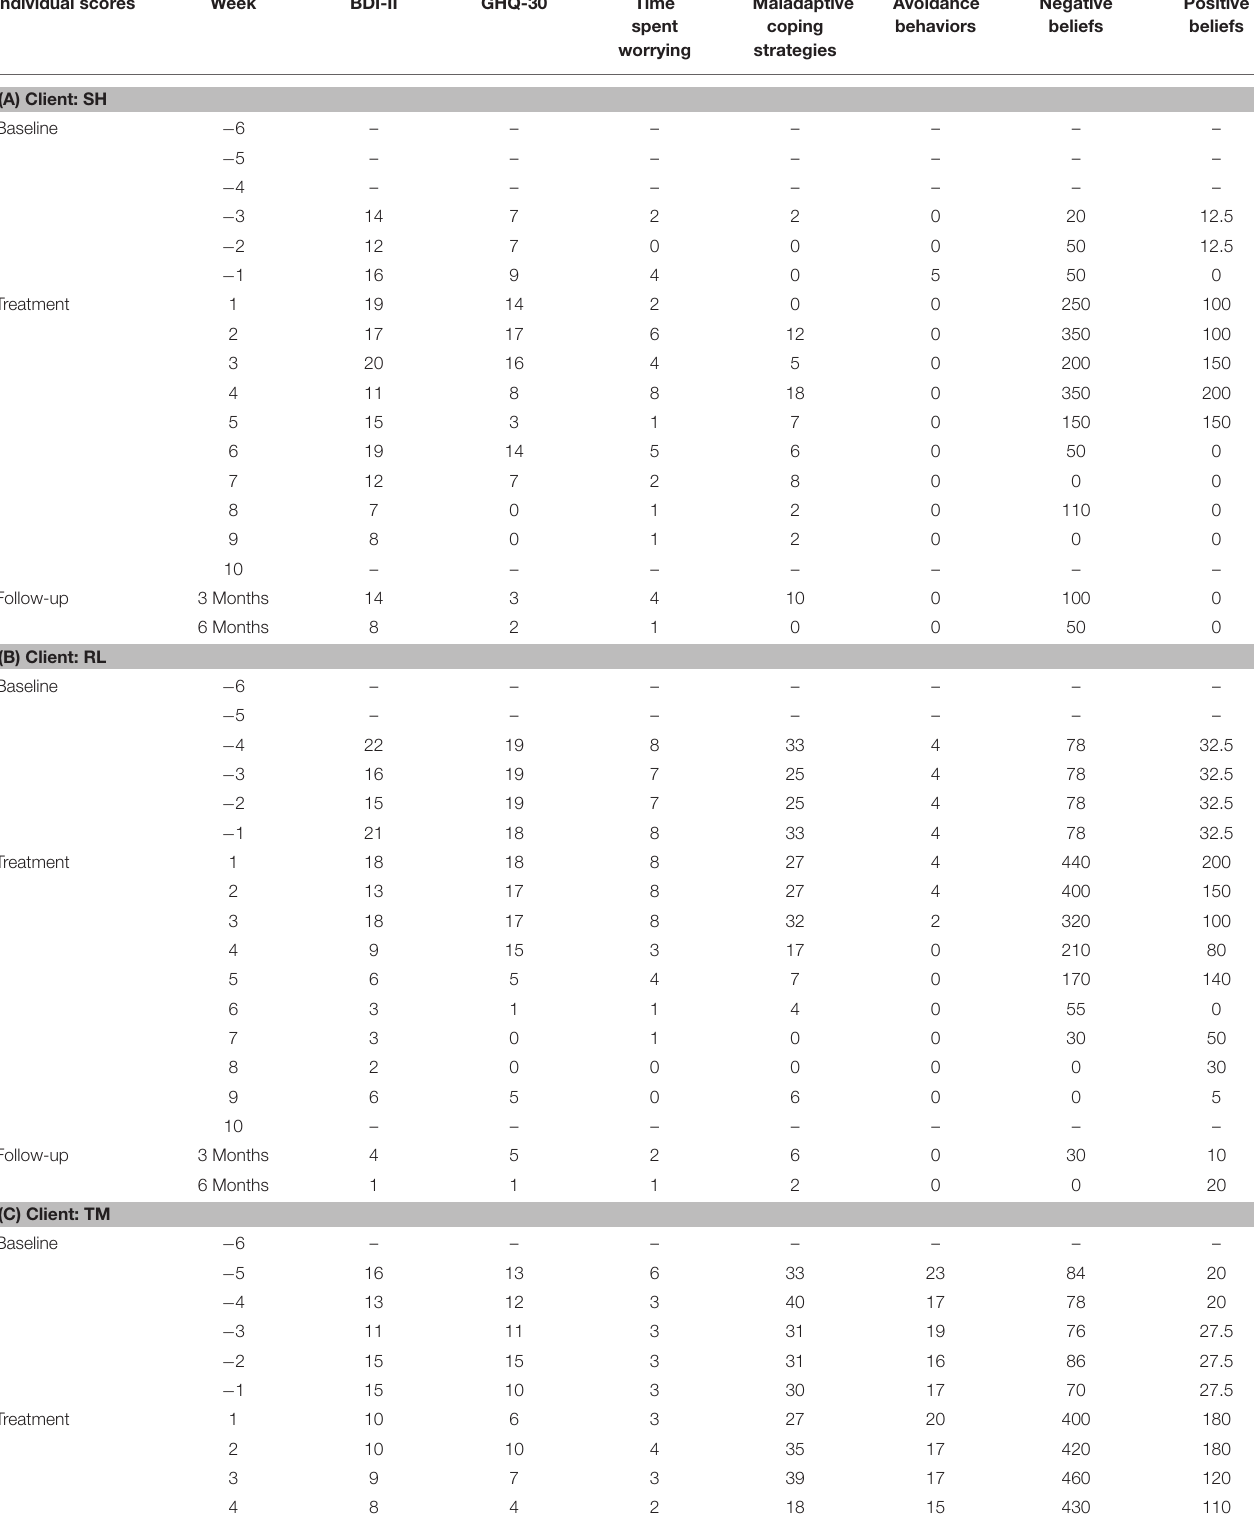
TABLE 1A–D | Individual scores of each client on primary and secondary outcome variables. Individual